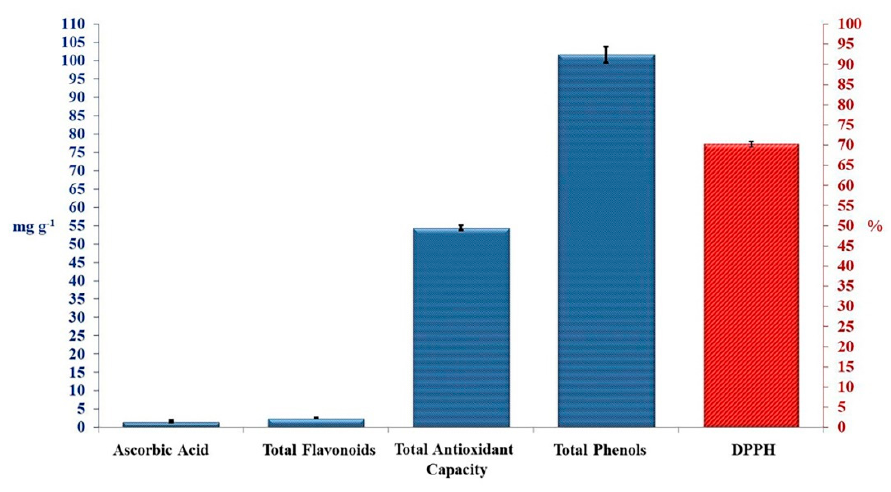
Figure 1. Antioxidant activities of crude TAM ® . Error bars indicate standard deviations of three replicates.